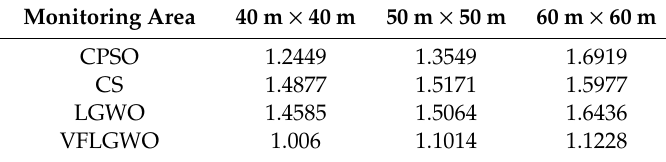
Table 10. Uniformity in different size monitoring areas.